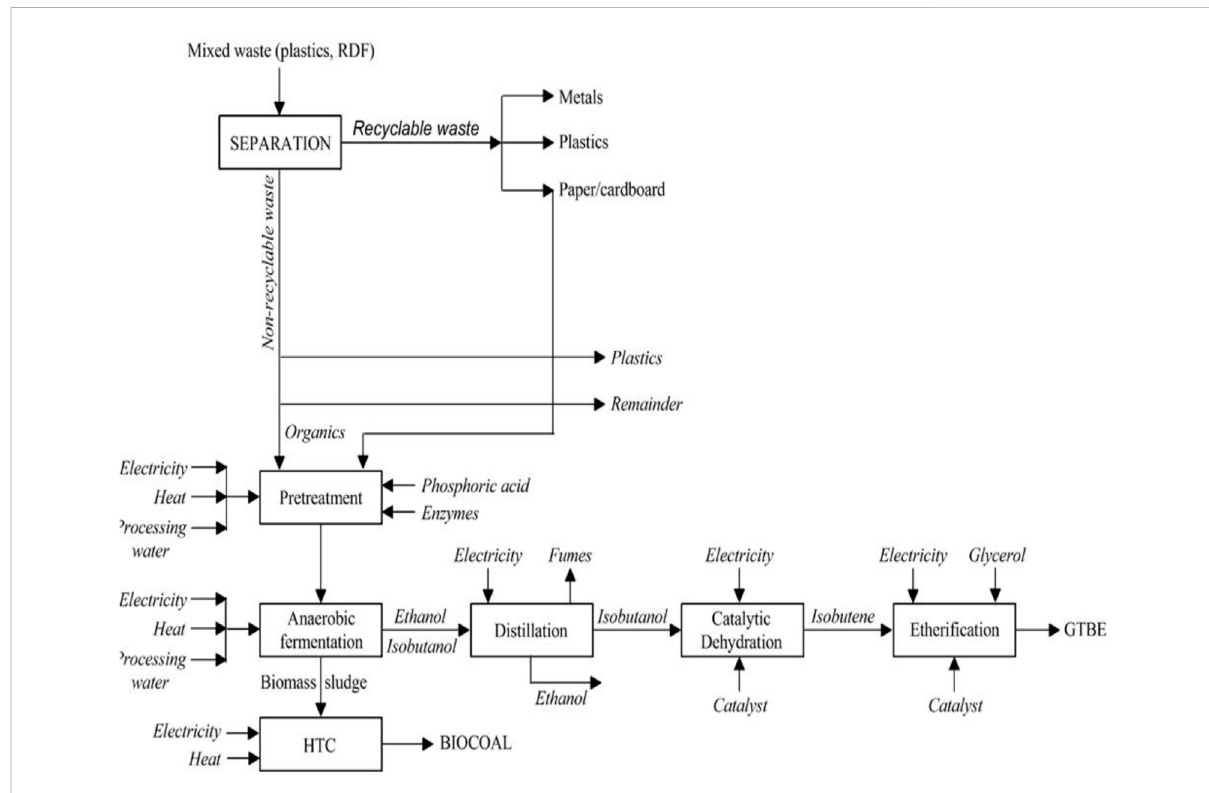
FIGURE 4 Flow sheet of Renasci innovative SCP (BioRen,